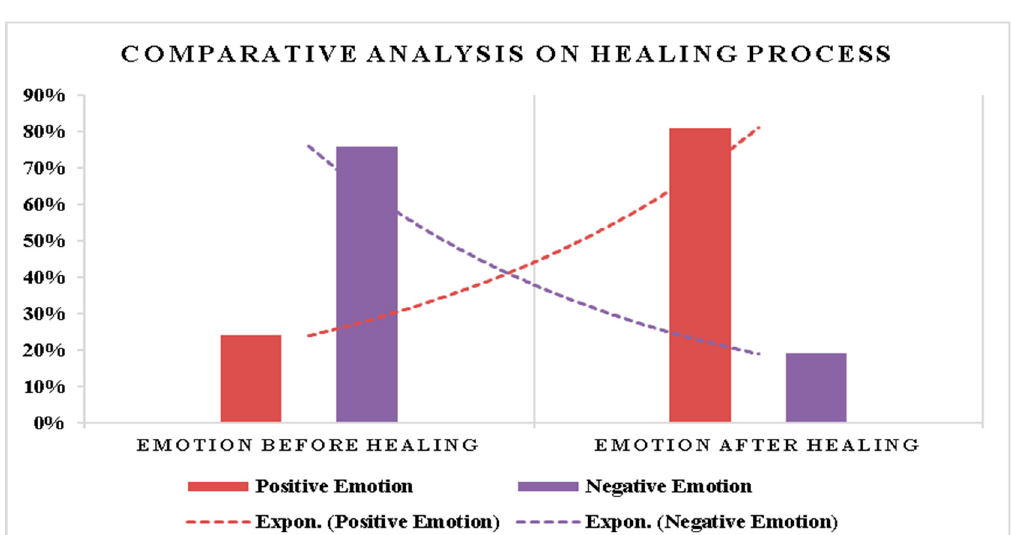
Figure 14. Comparative analysis of the healing process.